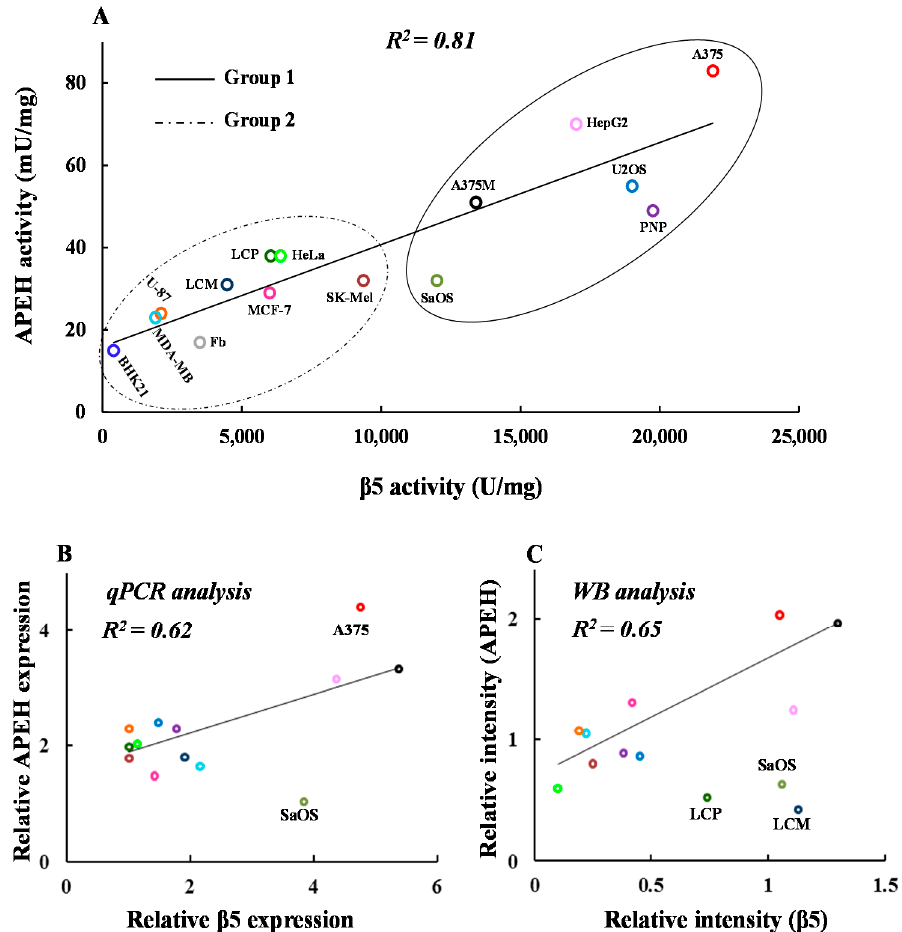
Figure 1. Activity, mRNA and protein levels of acylpeptide hydrolase (APEH), and proteasome correlate in a wide panel of cancer cells. Thirteen human cancer and two non-cancerous cell lines (BHK21, fibroblasts) were harvested at the pre-confluent stage and used for protein cytoplasmic or mRNA extract preparations. ( A ) Basal APEH and proteasomal CT-like ( β 5 subunit) specific activities were measured; ( B ) the mRNA levels of APEH and β 5 proteasome subunit were evaluated by qPCR and reported as relative expression using the transcriptional levels in human fibroblast as control; ( C ) intracellular levels of β 5 and APEH were detected by immunoblotting analysis. Data from three different analyses were normalized to the density of control protein ( β -actin) and expressed as relative intensity. Results are presented as the mean values ± SD of triplicate analyses from at least three different experiments.